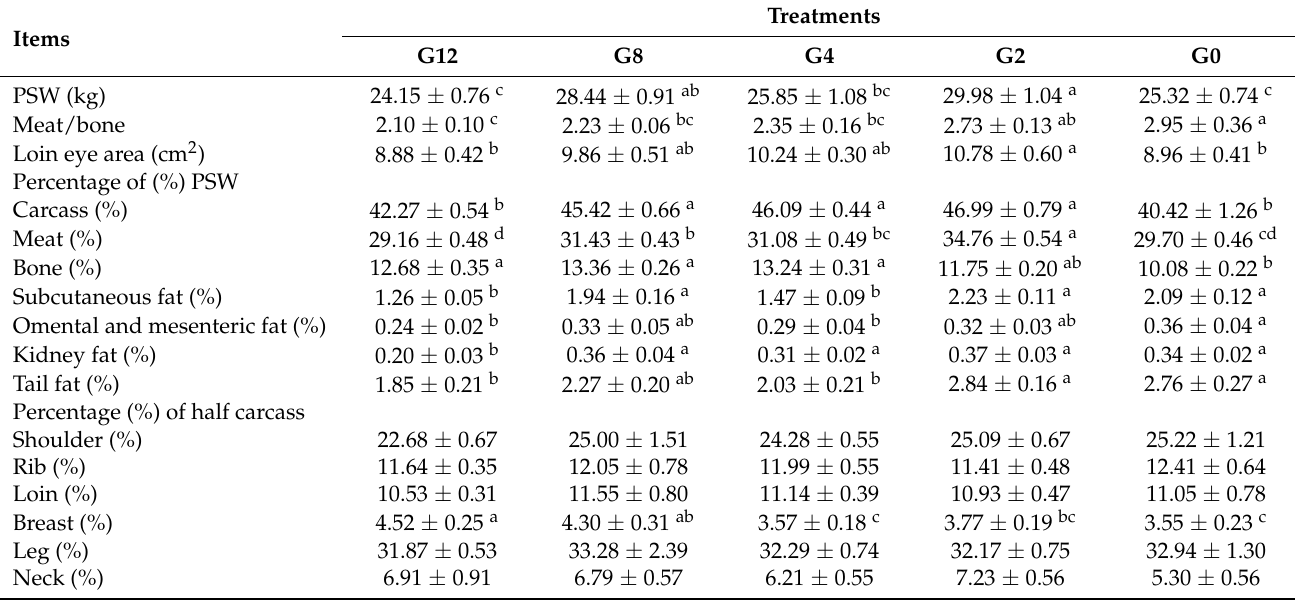
Table 3. Carcass traits of Tan lambs under different restricted grazing time and indoor supplementary feeding systems.